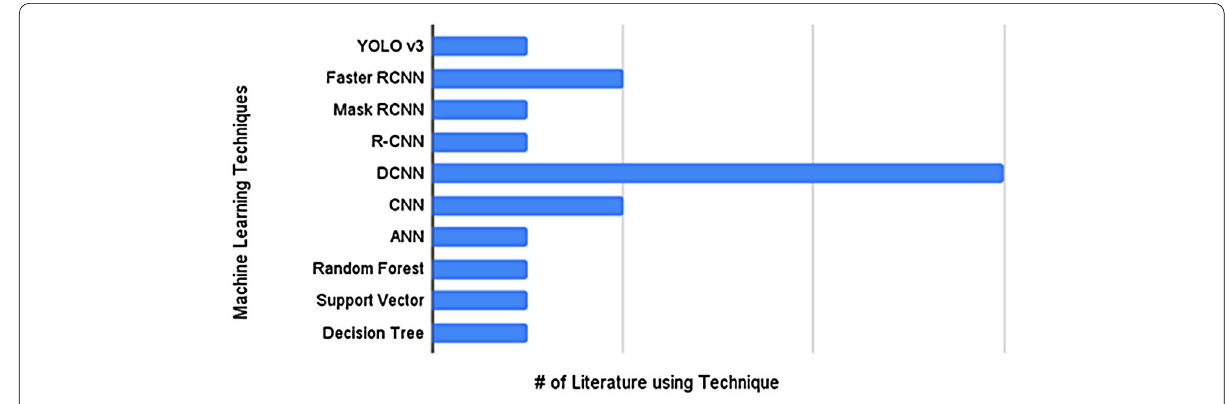
Figure 2 The use of different Machine Learning techniques in